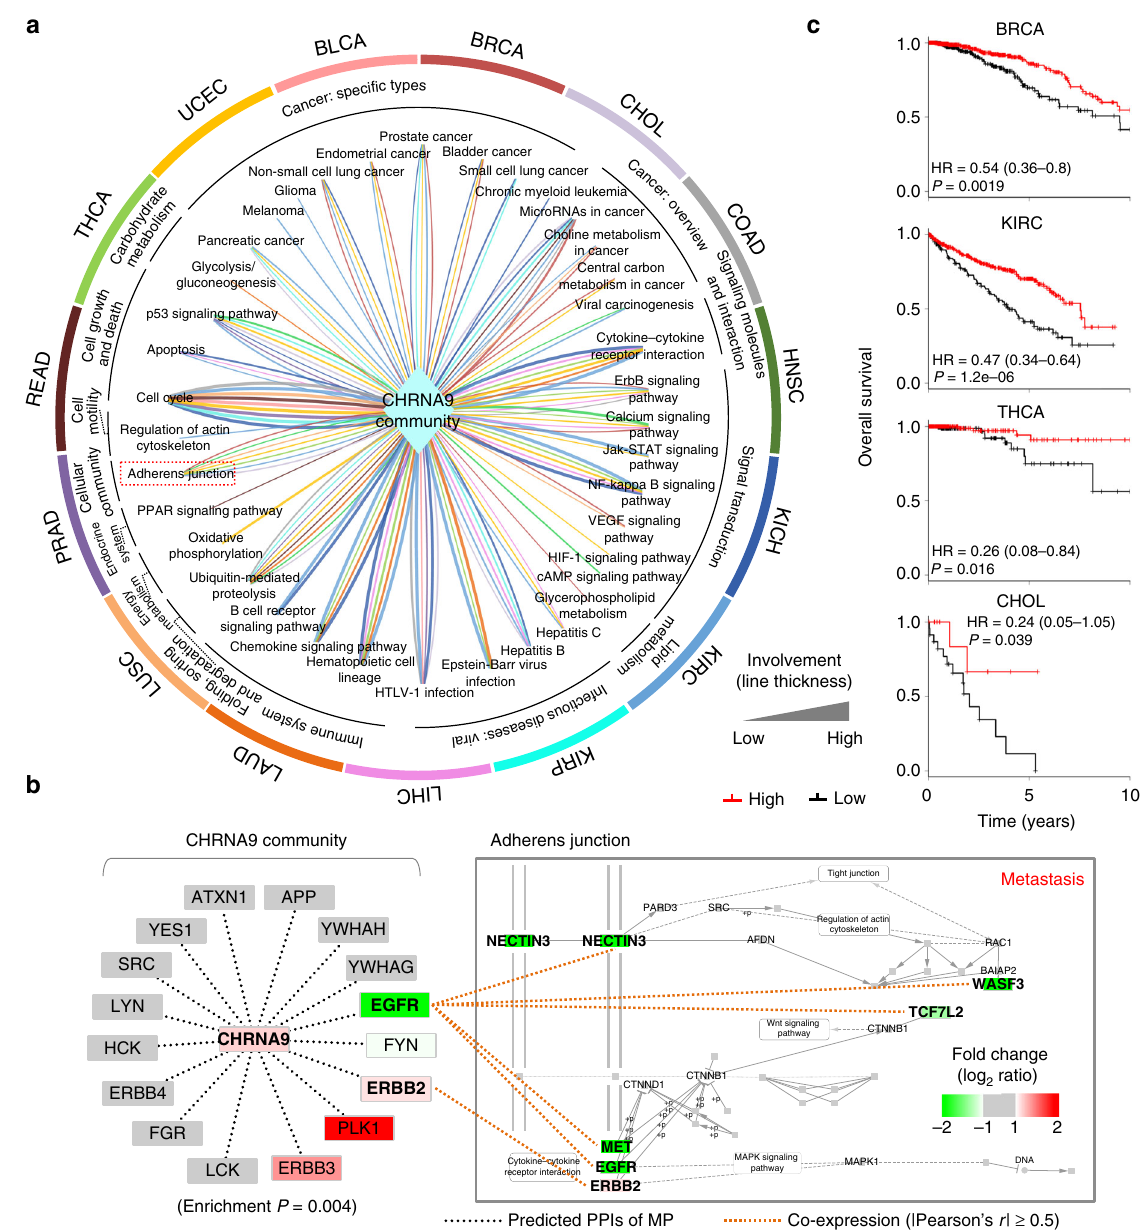
Fig. 5 Nicotinic acetylcholine receptor subunit α 9 (CHRNA9) community-regulated networks in cancers. a CHRNA9 cancer membrane protein-regulated networks (CaMPNets) containing 38 cancer-related pathways in 15 cancer types. CHRNA9 and its interacting proteins (i.e., CHRNA9 community) are depicted as a rhombus. These 38 pathways are grouped and labeled according to their Kyoto Encyclopedia of Genes and Genomes categories surrounding the pathway outlines. The colored outlines surrounding the CaMPNets indicate that certain pathways are regulated by the CHRNA9 community in speci fi c cancer types. The thickness of the lines is proportional to the signi fi cance of involvement ( − log 10 enrichment P ). For example, the CHRNA9 community apparently involves the cell cycle, which is relevant to cell growth and death in most cancers, and participates in adherens junction and vascular endothelial growth factor signaling pathways, which are related to cell adhesion and communication, in BRCA (red) and LUSC (light orange). Source data are provided as a Source Data fi le. b CHRNA9 community-regulated adherens junction in BRCA. The squares with colors and bold letters represent genes in this community-regulated pathway. The black dotted lines denote predicted protein – protein interactions. The orange dotted line indicates a co-expressed gene pair (Pearson ’ s r ≥ 0.5 or ≤ – 0.5) between genes in the CHRNA9 community and adherens junction. In this pathway, upregulated (red) and downregulated (green) genes, co-expressed with genes in the community, and their interacting neighbors are labeled with gene names. c Kaplan – Meier survival plots of differences in 10-year overall survival for BRCA, KIRC, thyroid Carcinoma (THCA), and cholangiocarcinoma (CHOL) patients strati fi ed by the combined score of genes in the CHRNA9 community-regulated adherens junction. Curve separation was assessed by log-rank